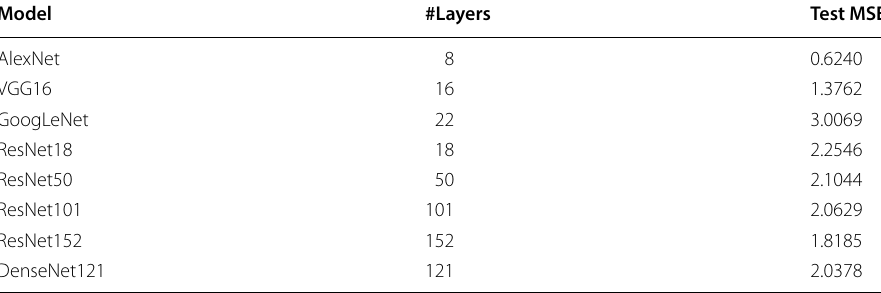
Table 3 Model performance on test